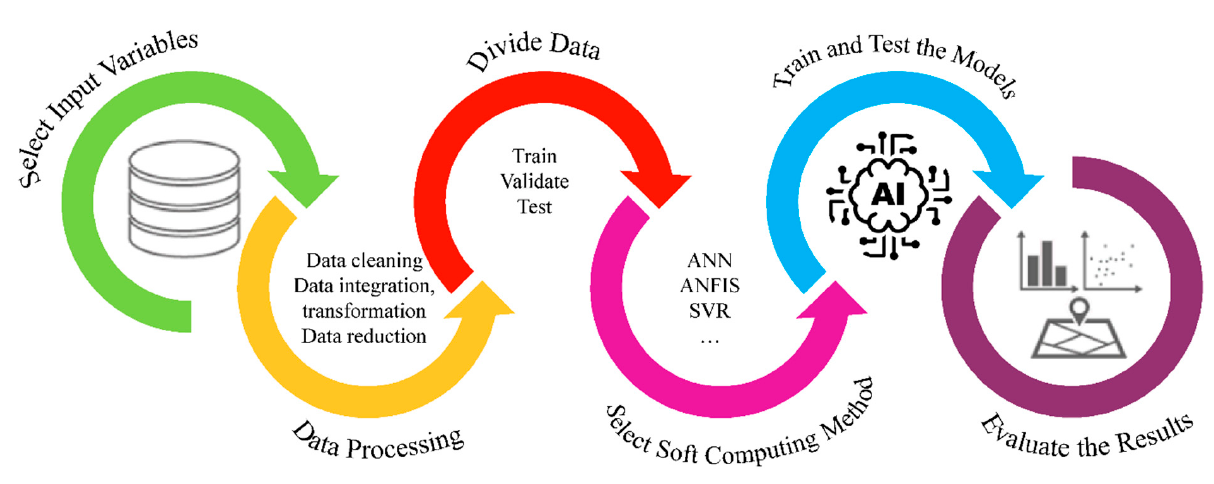
Figure 5. Steps of seepage modeling via soft computing methods.